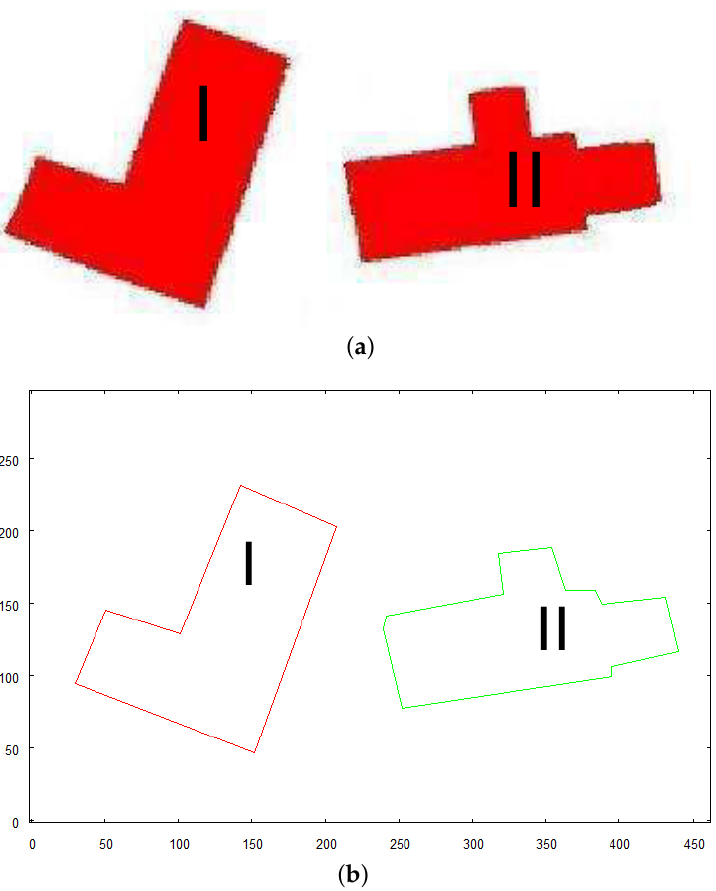
Figure 9. Structures that will be passed to recognition algorithm to locate them in scene. ( a ) prepro- cessed image; ( b ) vector